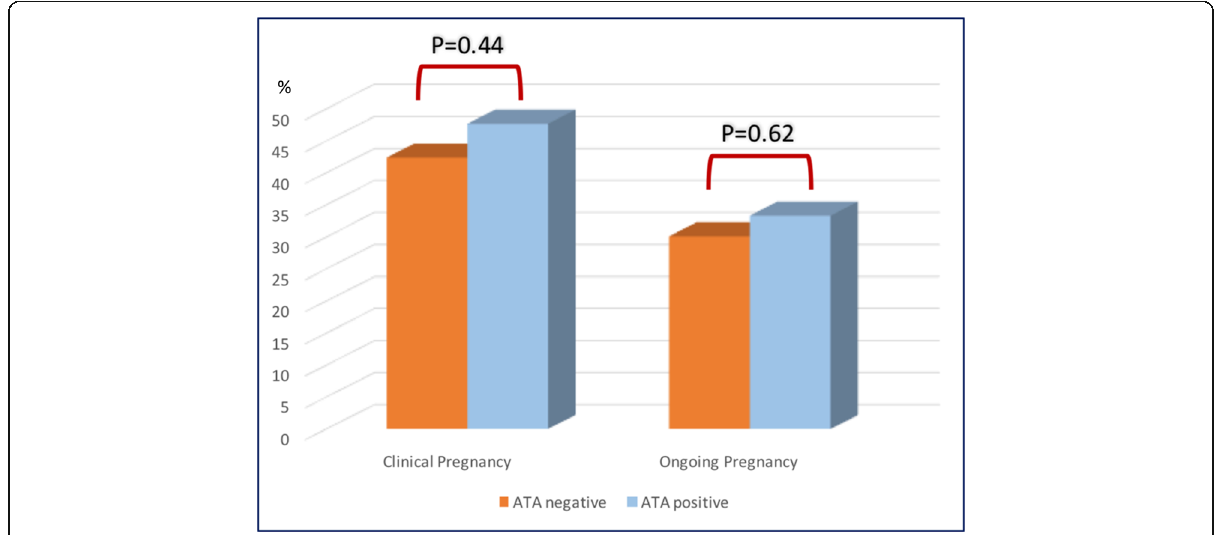
Fig. 1 The pregnancy outcomes of